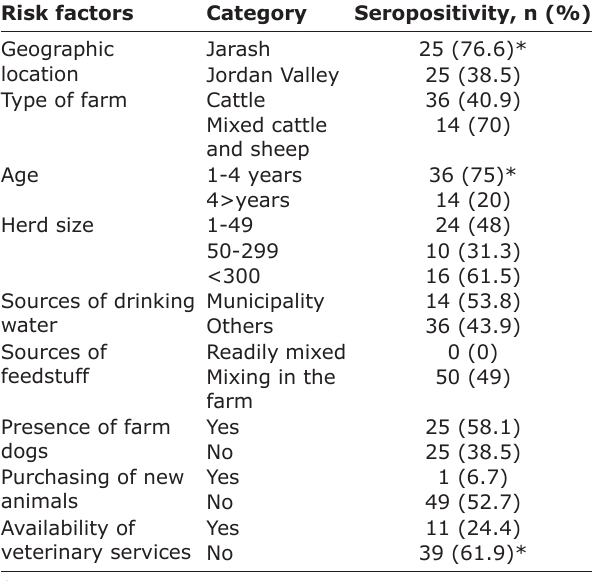
Table-2: Univariate analysis of risk factors associated with high seropositivity against bovine ephemeral fever virus in dairy cattle (n=108).